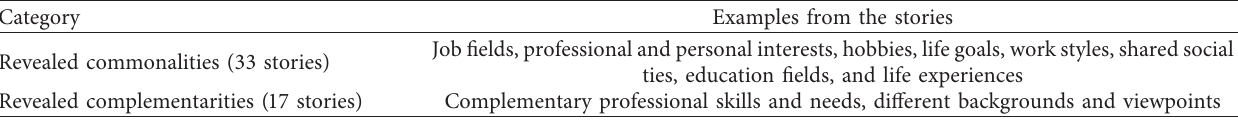
Table 4: Categories of the connection phase identified in the respondents’ stories.